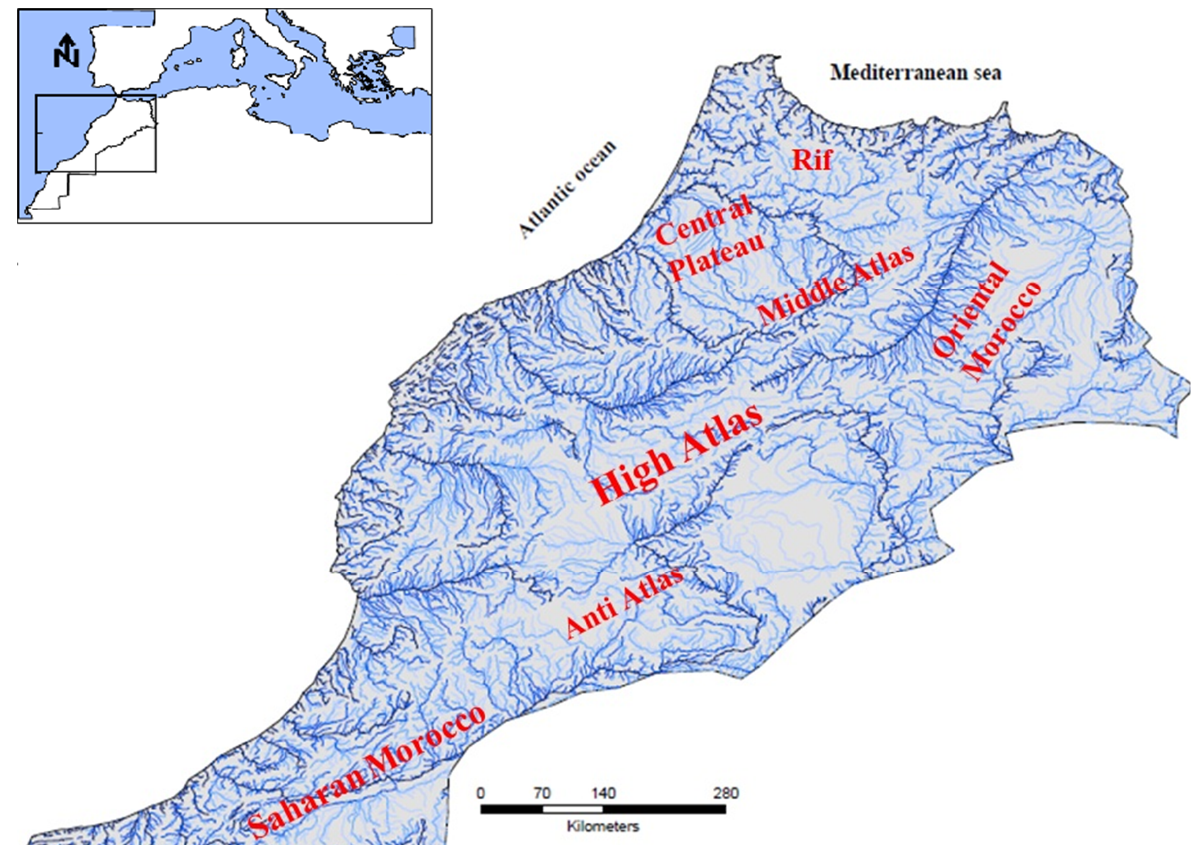
Figure 1. Different hydrographic networks and biogeographic areas of Morocco.